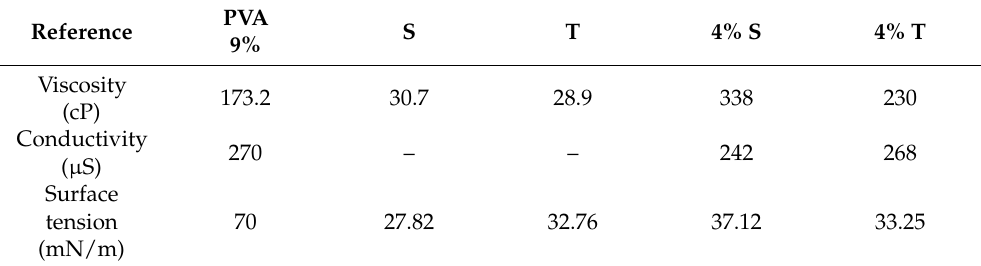
Table 1. Properties of the emulsions used.